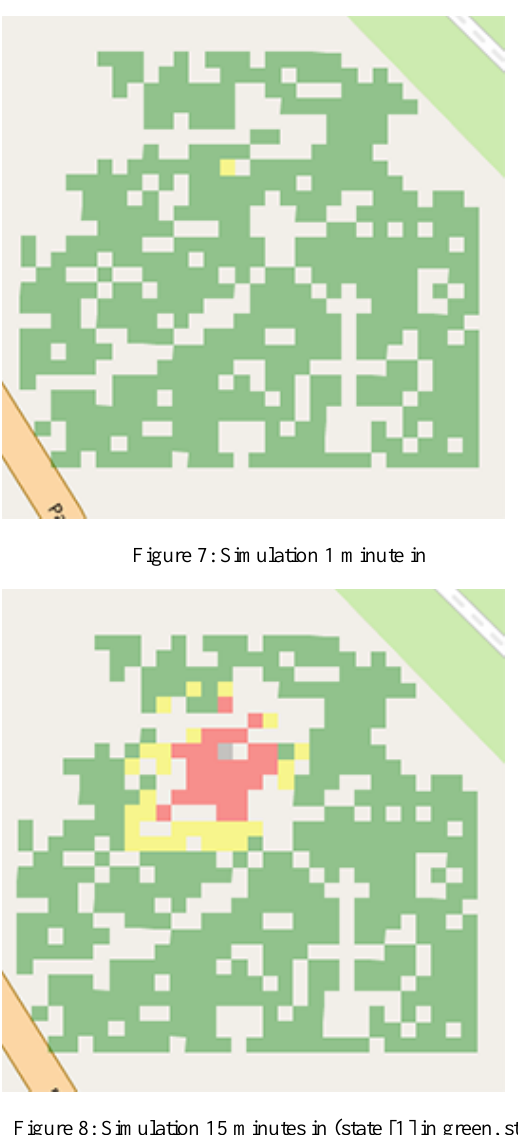
Figure 8: Simulation 15 minutes in (state [1] in green, state